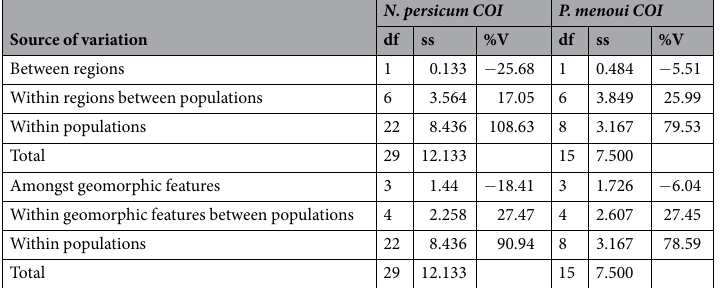
Table 2. Hierarchical AMOVA results for Neoaulaxinia persicum and Pleroma menoui when tested for genetic variation at the COI mitochondrial gene. Significant values of p < 0.05 are marked as * , and p < 0.01 are marked as ** .